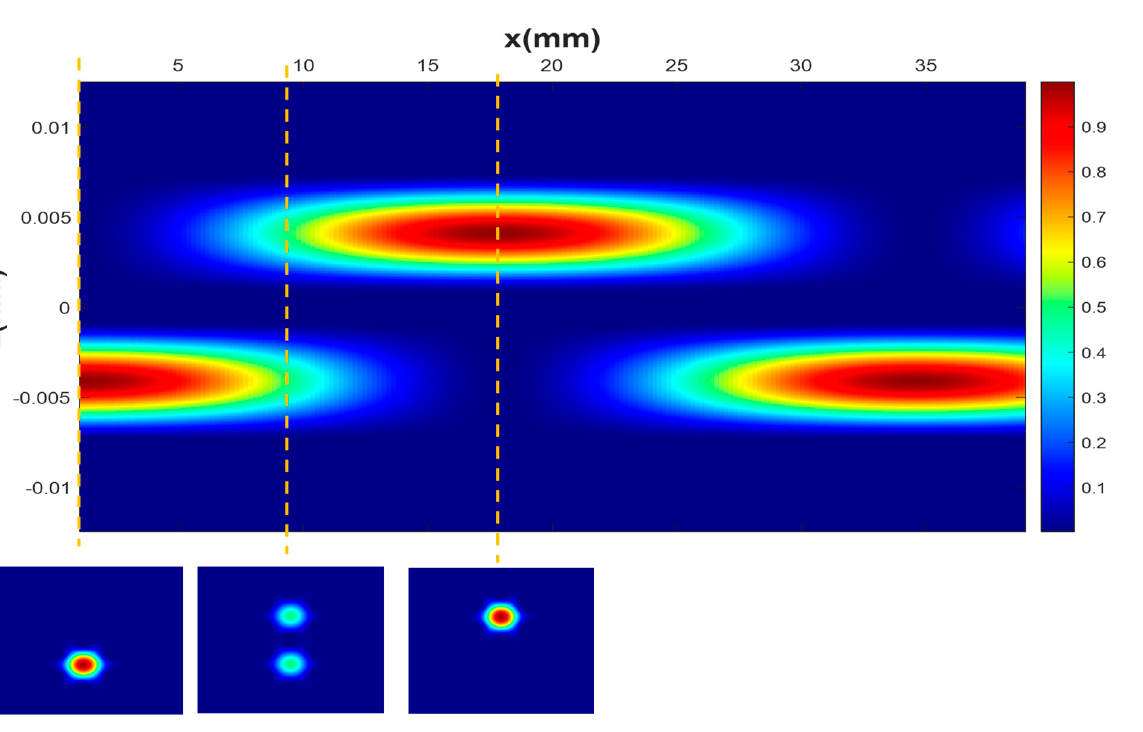
Figure 5. Power oscillations between cores along the longitudinal axis of the mPOF. Figures at the bottom show the near-field patterns at the cross-sections of the mPOF that are marked with dashed lines.